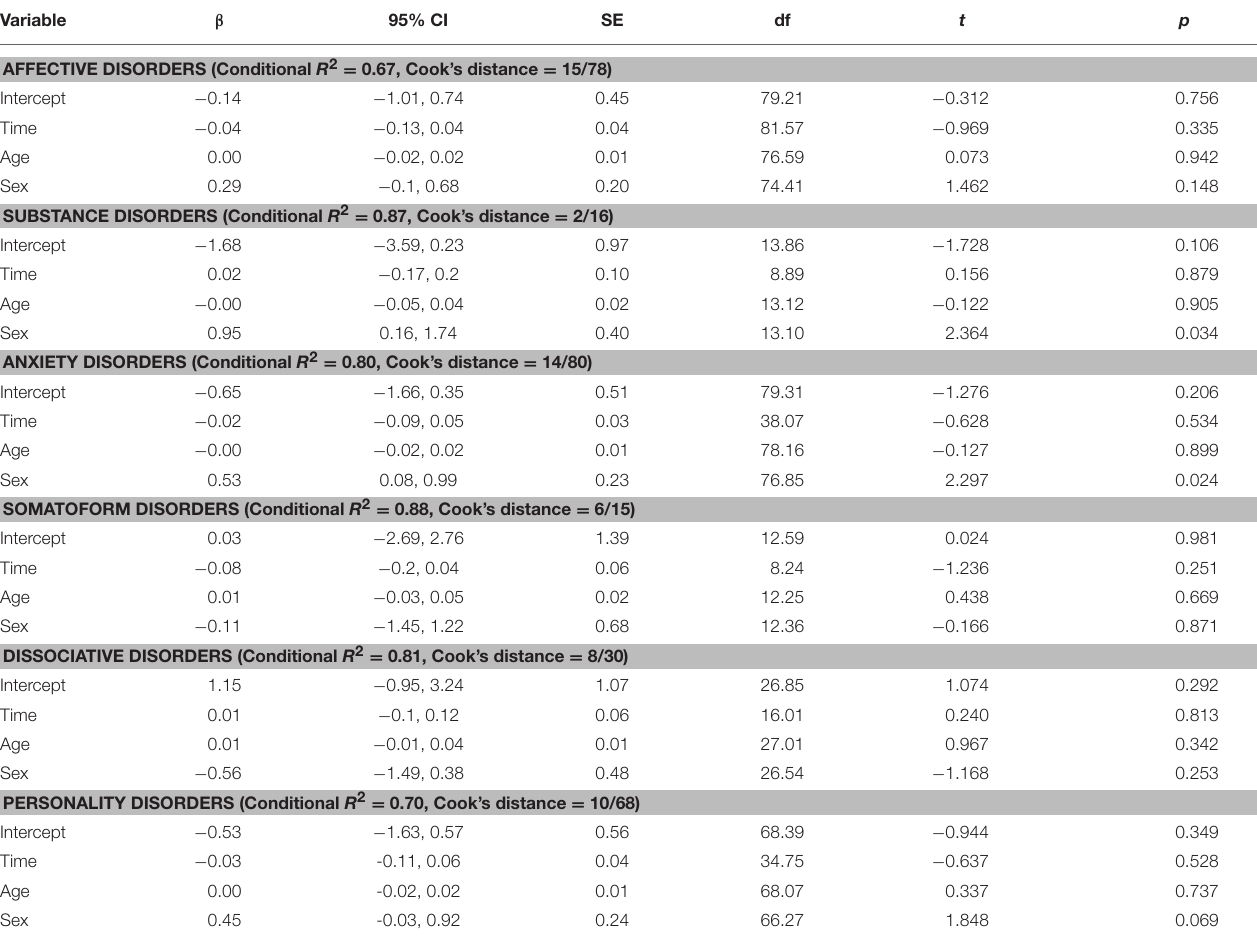
TABLE 3 | Results of linear mixed effect models on the 18-month course of functional impairment across WHODAS II domains of outpatient and daycare patients ( N = 155). Variable β 95% CI